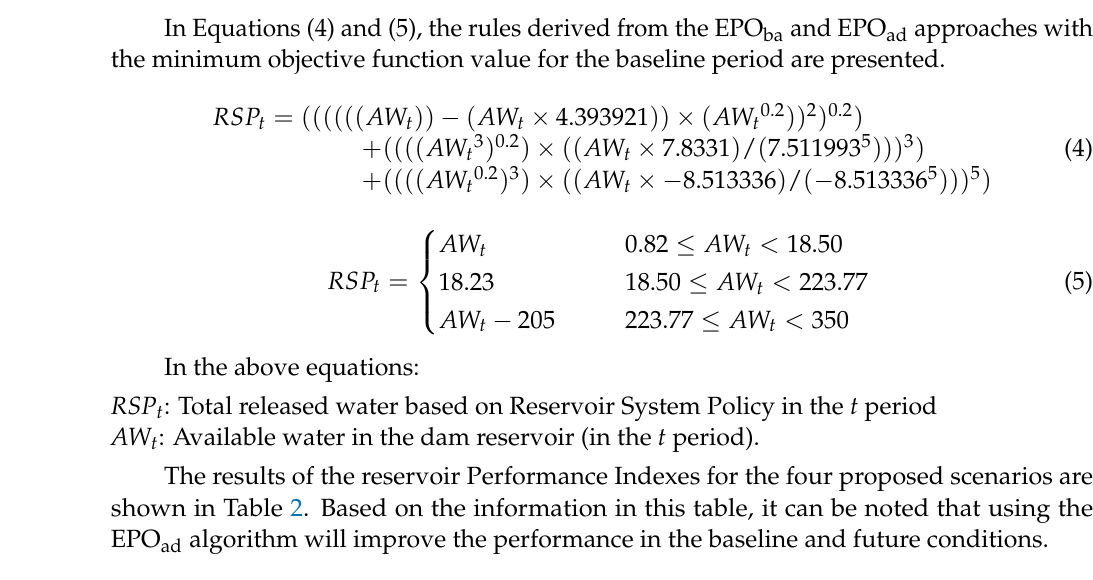
Table 2. Vulnerability and reliability indexes in the four